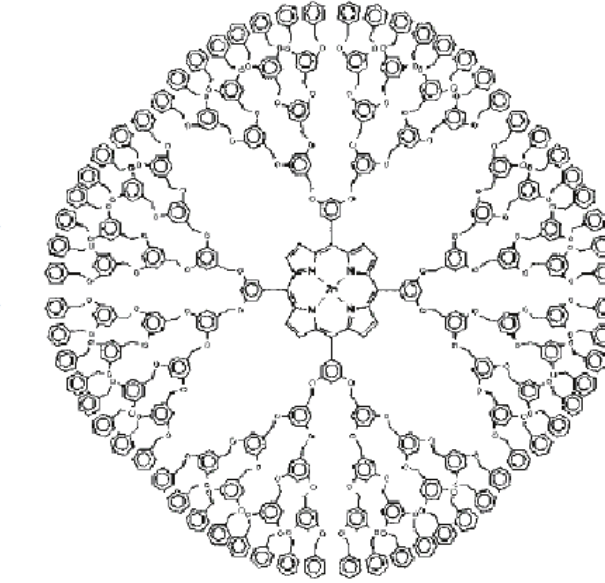
Figure 1: Porphyrin Dendrimer.